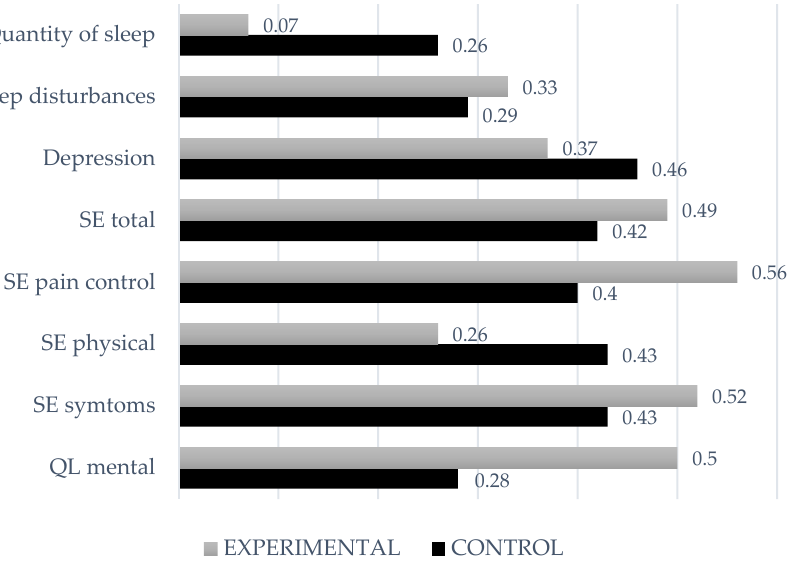
Figure 2. Effect sizes (d) for the experimental and control groups for the variables in which both groups improved significantly.